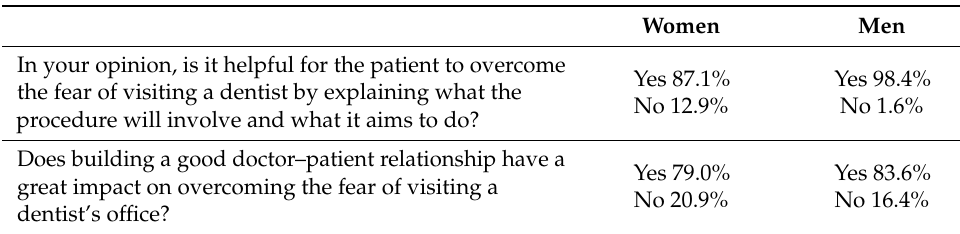
Table 6. Patient assessment regarding the explanation of the treatment and purpose of the